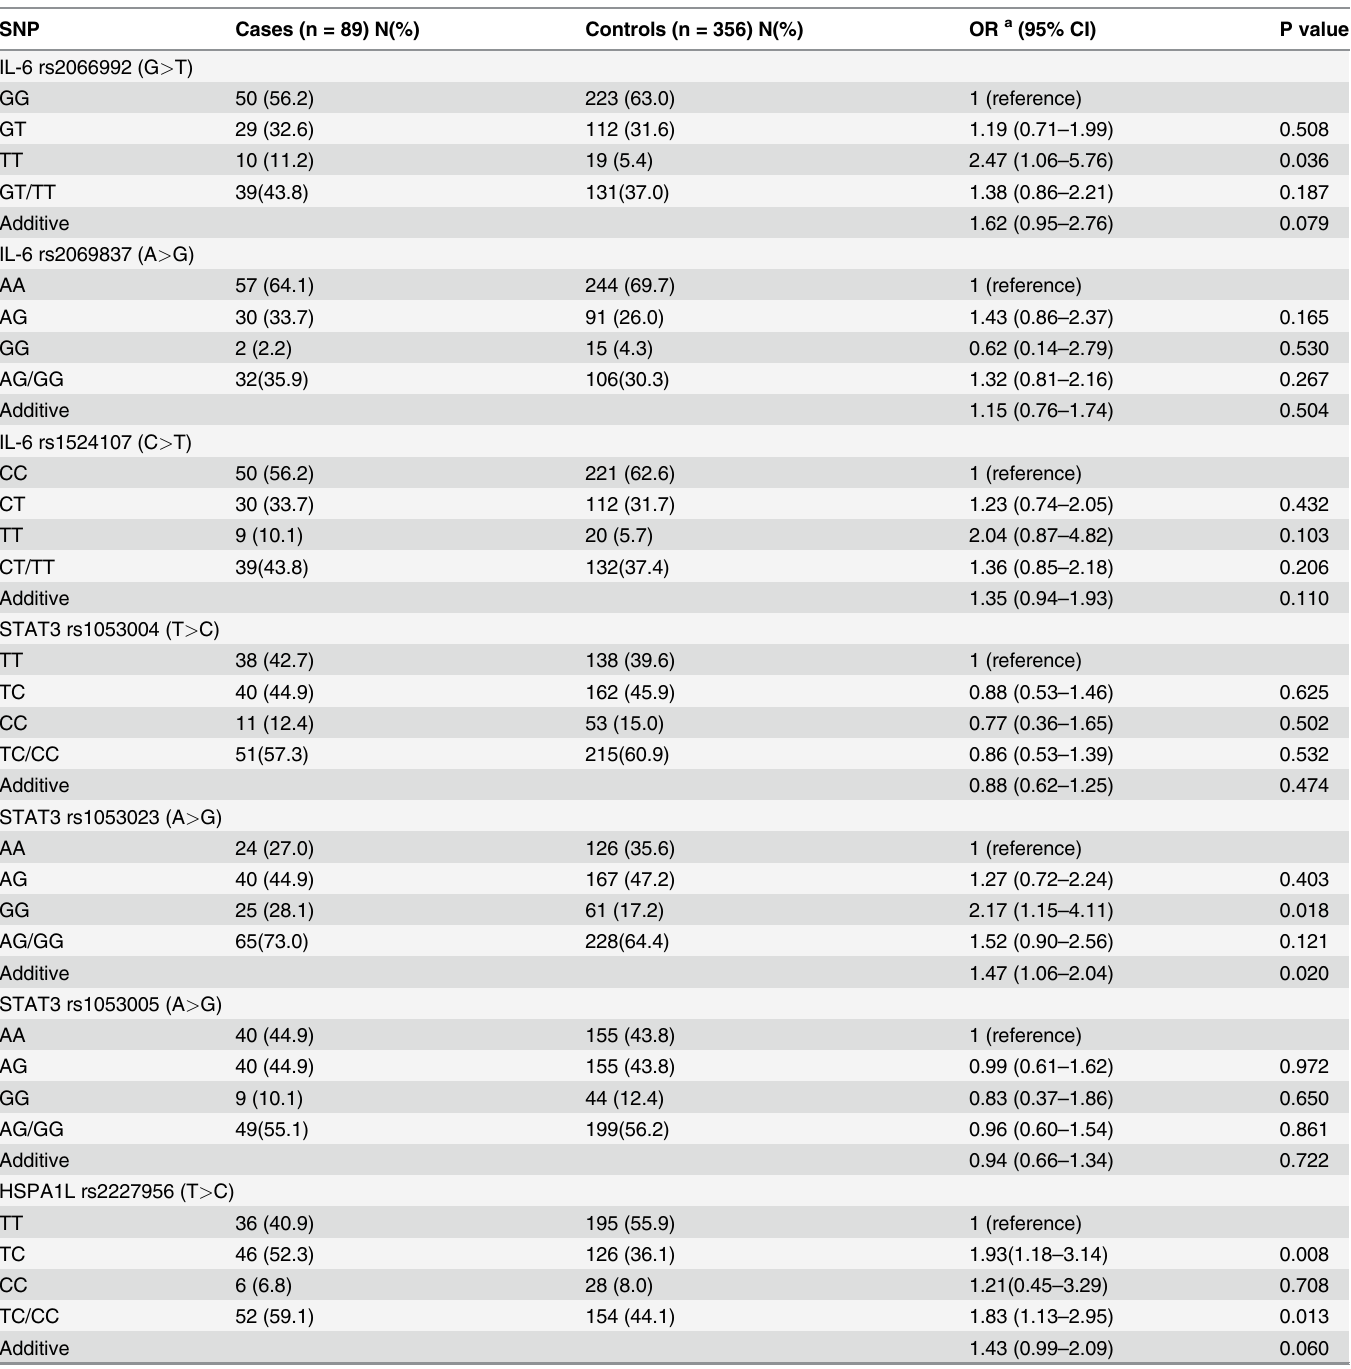
Table 3. IL-6, STAT3 and HSPA1L Polymorphisms in Patients with and without